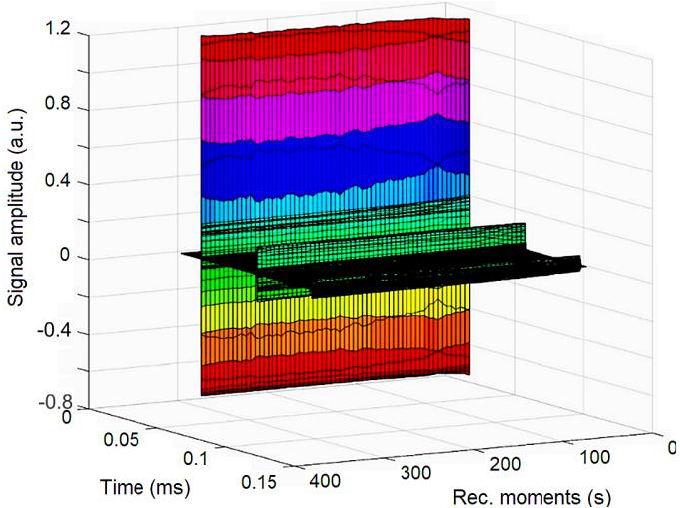
Figure 3. Recorded signals at 5 s recording interval. The amplitudes of the first echo are slowly increasing (in colors). The second (green) and third (black) echo are significantly weaker.